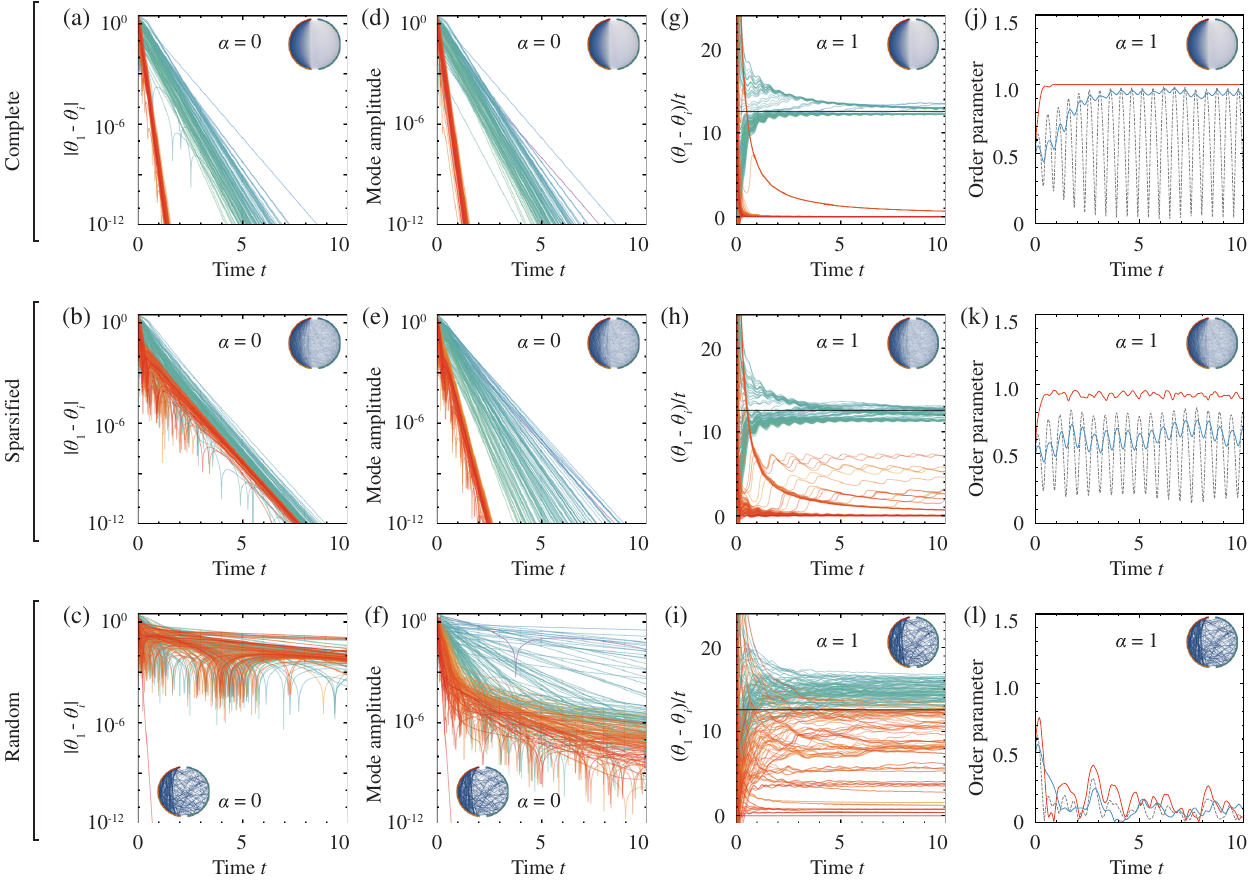
FIG. 2. DBG networks lead to staggered synchronization and chimeras. (a) – (f) In the Kuramoto model with α ¼ 0 , the complete (first row) and sparsified (second row) graphs synchronize much faster than the random graph (third row). For the complete graph the gap affects the rate of synchronization, with highly connected vertices synchronizing faster (a), while on the sparsified graph the gap is only visible in the mode basis (e). (g) – (i) Weak chimera states appear when α ¼ 1 . Both the complete (g) and sparsified (h) graphs have two dominant groups of phase-locked oscillators, with the complete graph more fully synchronized. Dynamics on the random graph (i) are much less coherent. Solid black lines indicate the predicted approximate frequency difference for a network with two distinct P e i θ j j for the simulations in (g) – (i) for the strongly connected vertices (red), eigenvalues, 5 and 20. (j) – (l) Order parameter r ¼ j j weakly connected vertices (teal), and all vertices (gray). See Video 1 in Supplemental Material [56] for